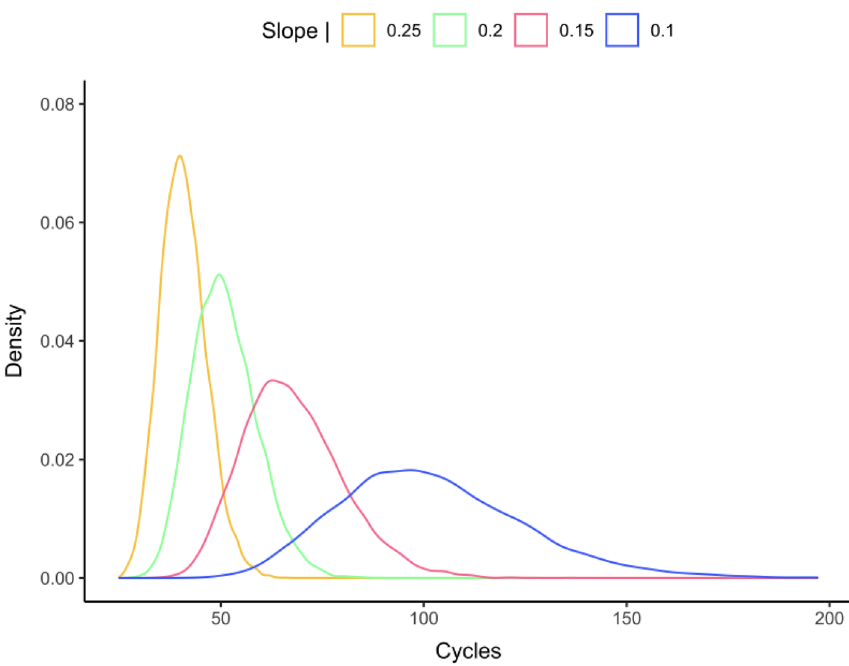
Figure 4. Distributions obtained with four different slopes applied to the same random walk model (starting point = 0; SD = 0.05; response criterion =